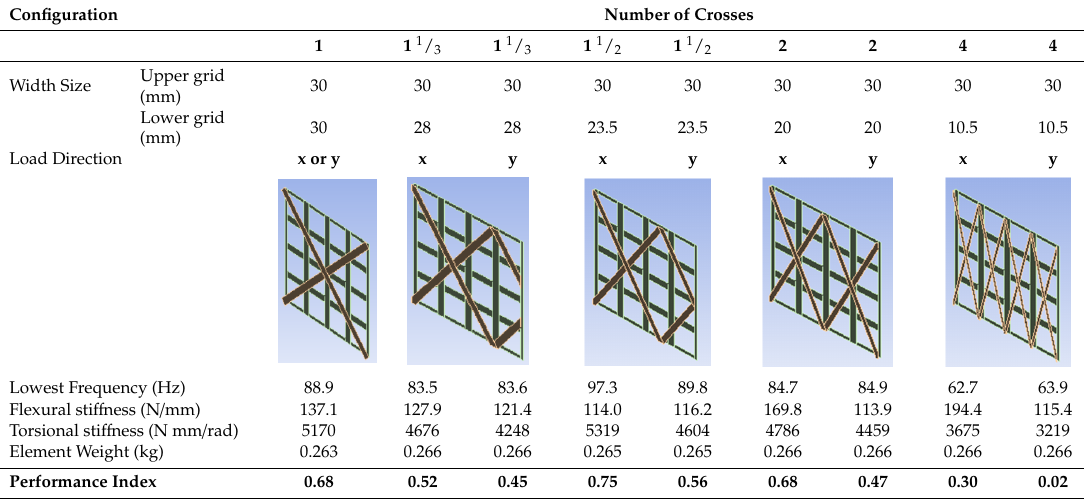
Table 6. E ff ect of changes in the crosses (at the level of basic unit). Table 6. Effect of changes in the crosses (at the level of basic unit). Table 6. Effect of changes in the crosses (at the level of basic unit). Table 6. Effect of changes in the crosses (at the level of basic unit). Table 6. Effect of changes in the crosses (at the level of basic unit). Table 6. Effect of changes in the crosses (at the level of basic